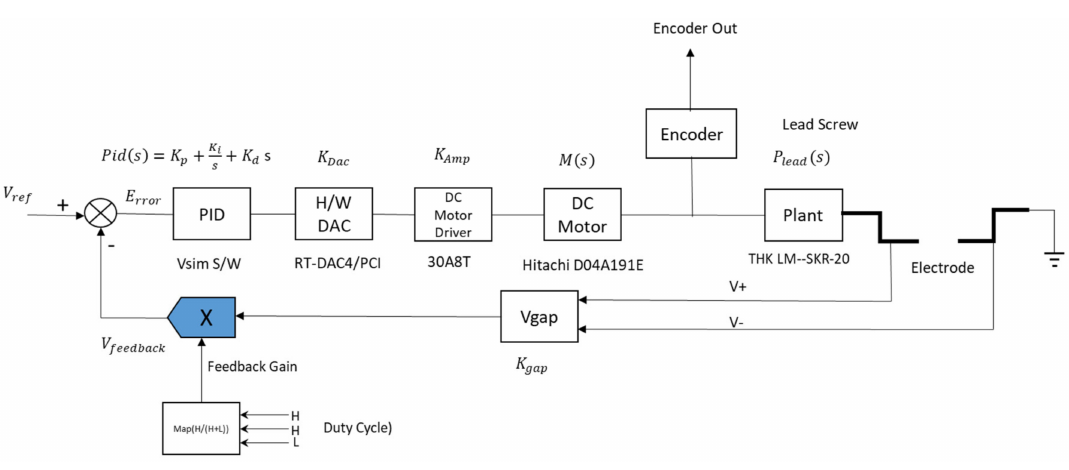
Figure 6. Micro-EDM system